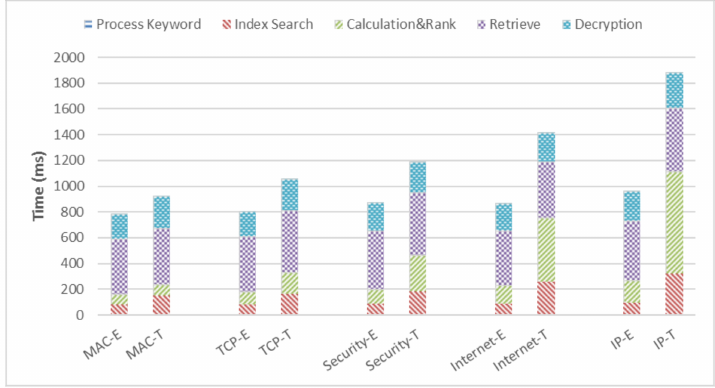
Figure 4. FSRT of ENSURE and Traditional Method: E represents ENSURE, T represents traditional